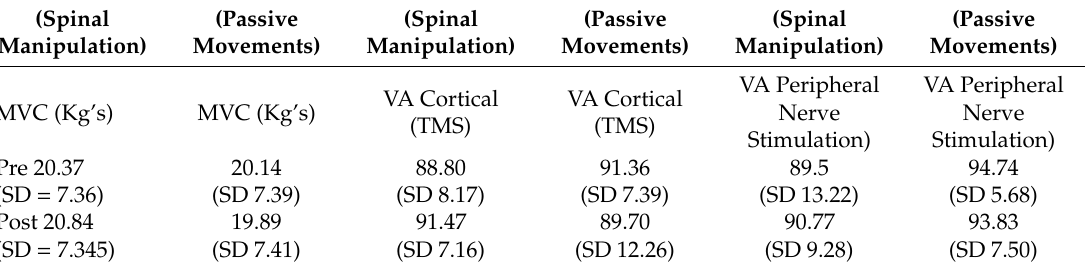
Table 1. Baseline and post mean values.